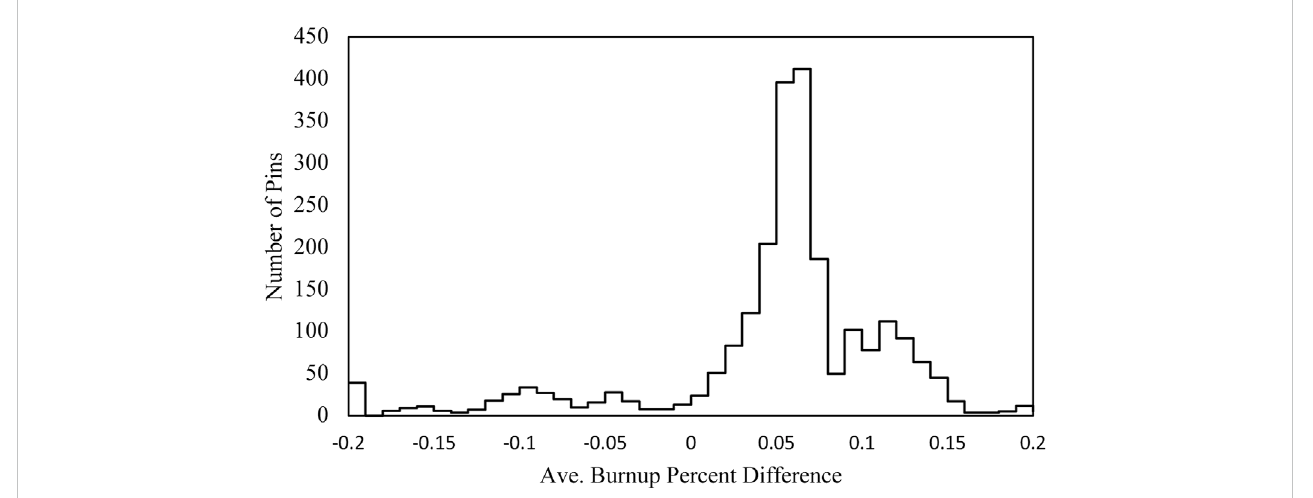
Difference in average burnup between BISON and Fuels Irradiation and Physics Database (BISON subtracted from FIPD).